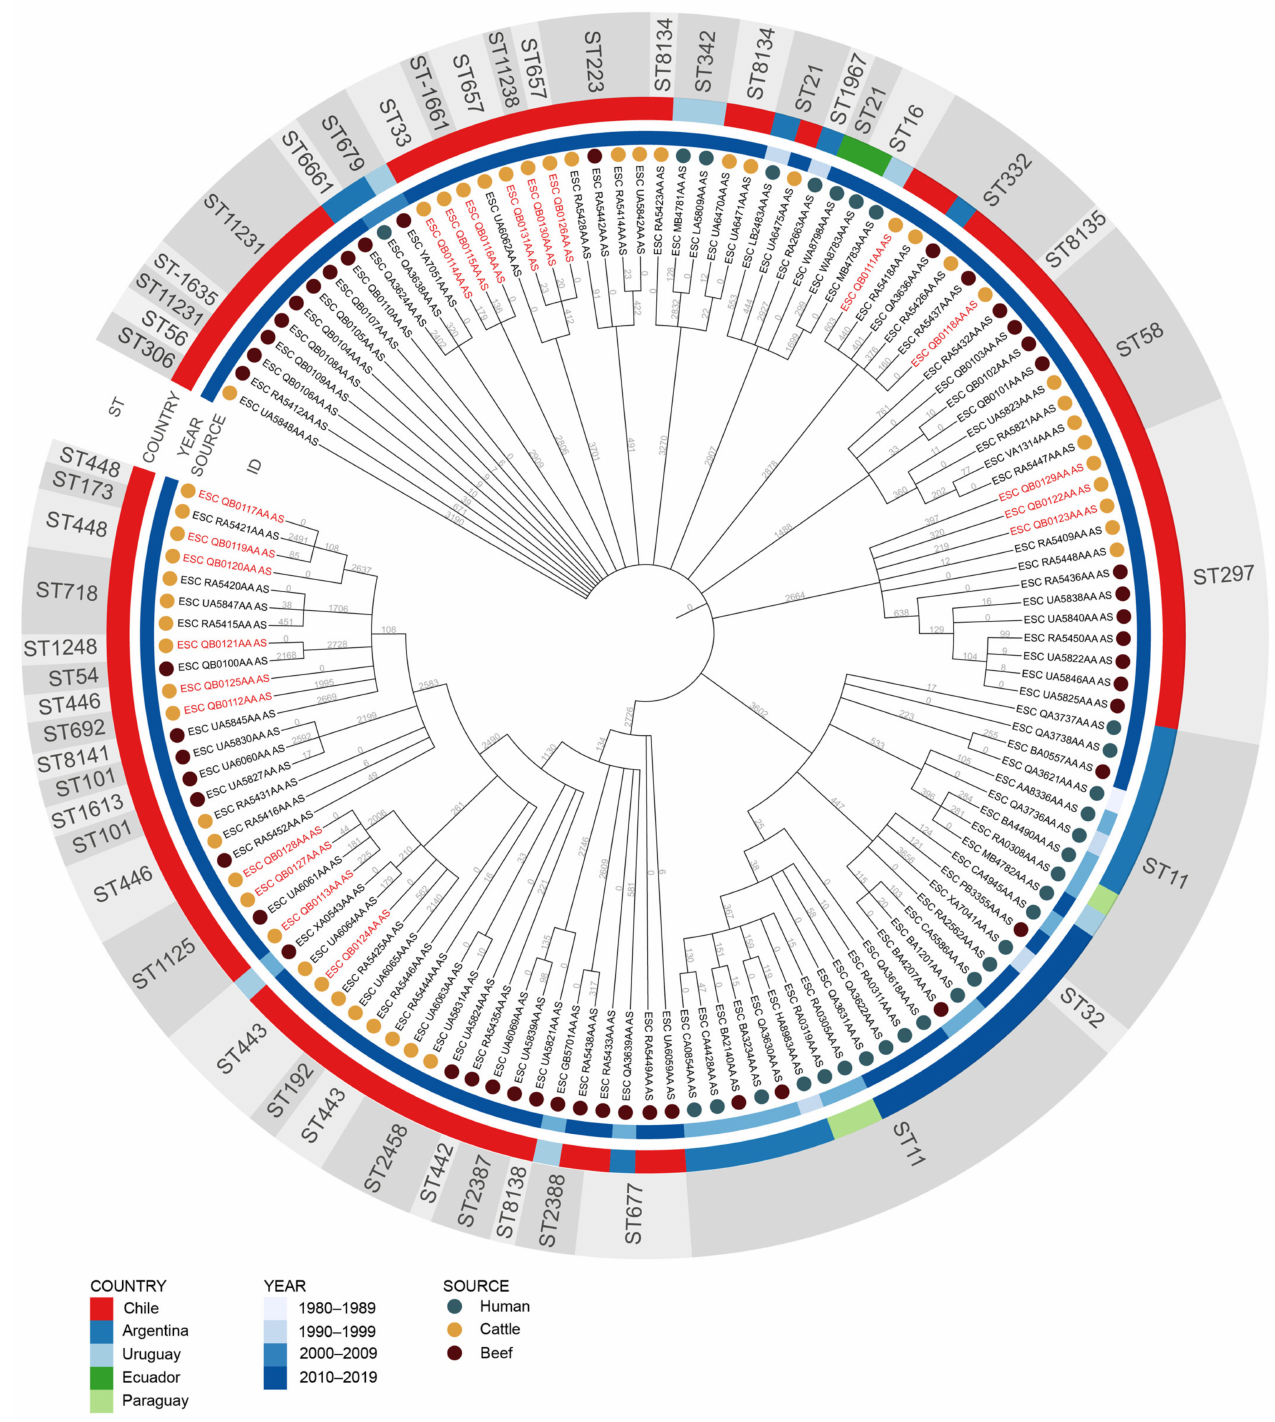
Figure 2. Minimum spanning tree for 130 STEC strains isolated from cattle, beef, and humans in South America, built by the MSTree V2 tool and wgMLST scheme from Enterobase. Escherichia coli sequence types (ST), country, year, and source of origin are compared. Genome IDs in red letters correspond to strains sequenced in this study. Numbers in the branches show the differences of wgMLST alleles between strains. An interactive version of the tree can be found at https://itol.embl.de/tree/179113207189378131606509422. SNP-based phylogenetic analysis confirmed genomic relatedness between STEC strains belonging to ST448/O148:H8 (B-18, B-19, and B-20, difference ≤ 246 SNPs), ST297/ O130:H11 (B-32, B-40, and RA-13, difference ≤ 339 SNPs, ST1125/-O:H19 (B-6, B-58,